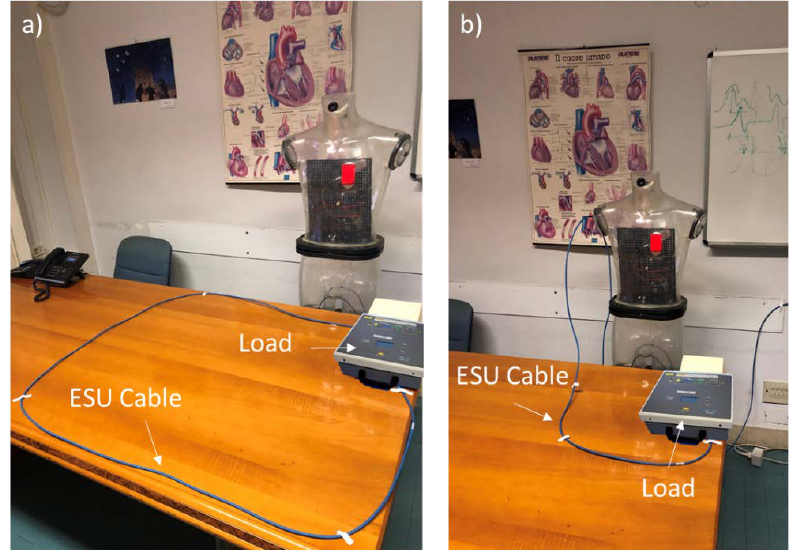
Figure 2. The experimental set-up adopted for testing the electrosurgical unit: ( a ) the electrosurgical unit (ESU) cable is arranged to maximize the resulting magnetic field; ( b ) the ESU cable is arranged to maximize the resulting electric field.